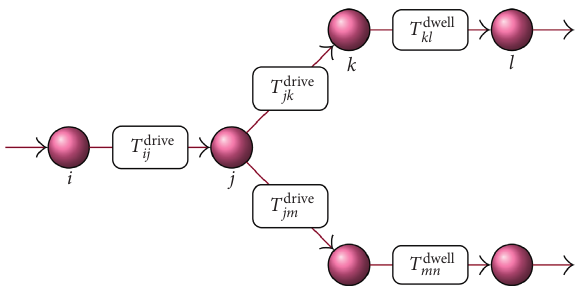
Figure 2: An example network representing part of a terminal. The arcs represent activities and the nodes events. The time of a process is denoted T , with the type of activity and the start and end node in superscript and subscript, respectively.